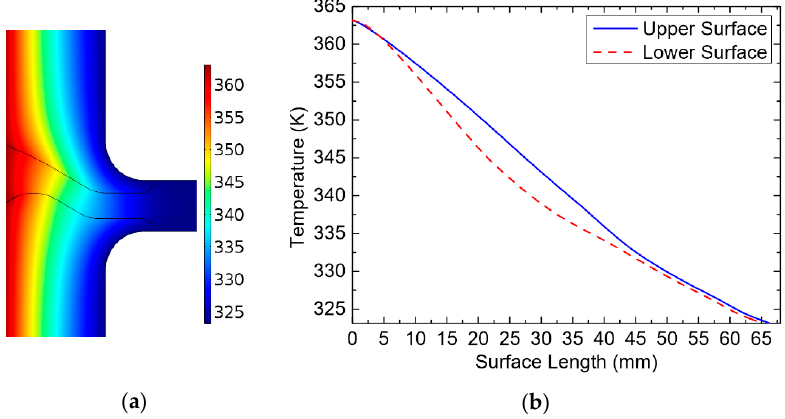
Figure 9. ( a ) Temperature distribution around the optimized spacer model with T c = 90 °C and T e = 50 °C. ( b ) Temperature distribution along the upper and lower surfaces.